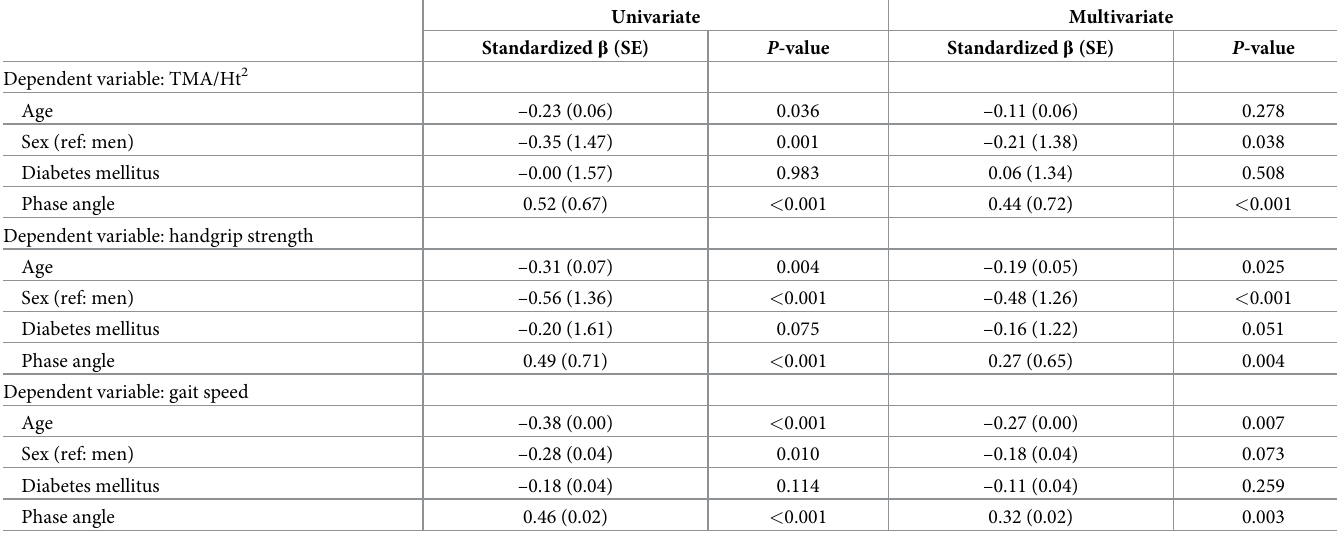
Table 4. Linear regression analyses of indices by phase angle.